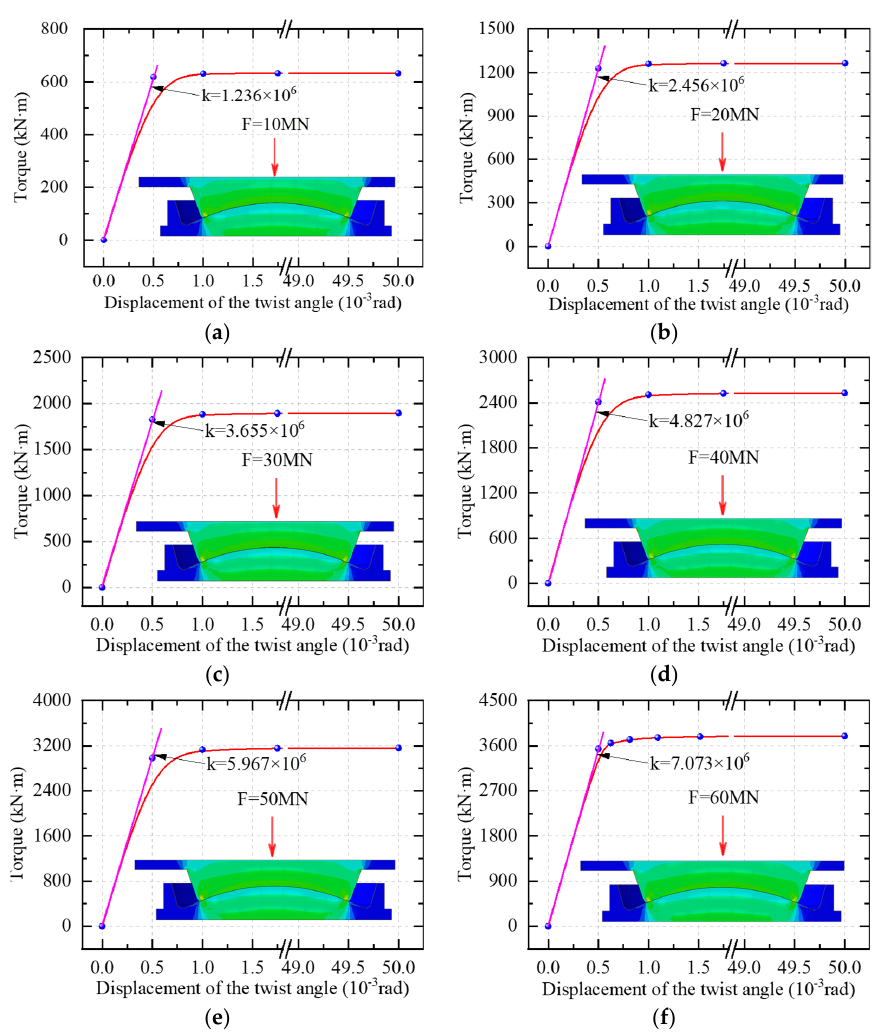
Figure 6. Load–displacement curve in six cases with different vertical forces: ( a ) the vertical force F=10MN; ( b ) the vertical force F=20MN; ( c ) the vertical force F=30MN; ( d ) the vertical force F=40MN; ( e ) the vertical force F=50MN; ( f ) the vertical force F=60MN.